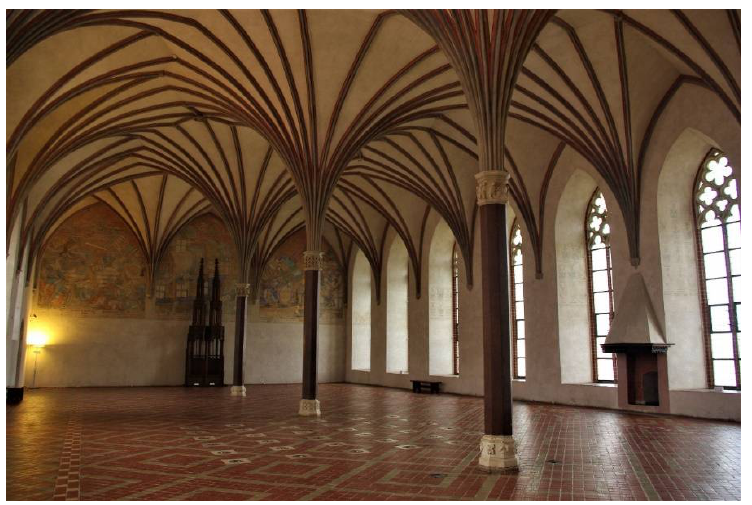
Figure 13. Malbork, Marienburg castle, Grand Refectory. Photo by Tomasz Ratajczak, the author’s own work.